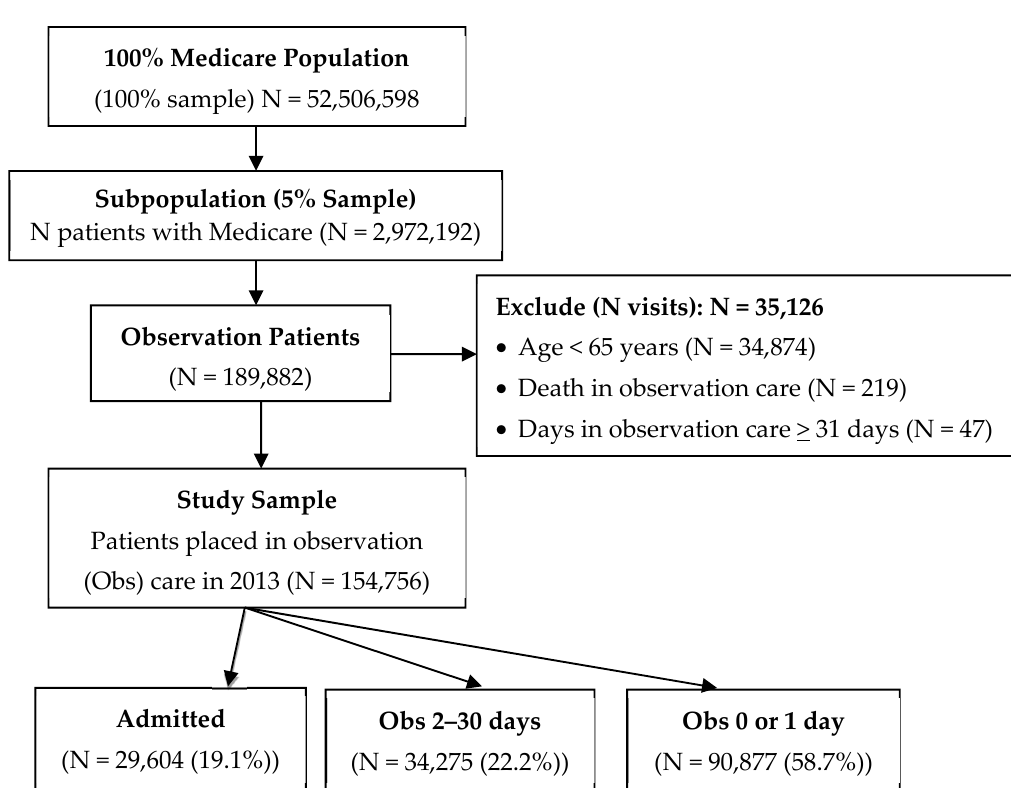
Figure A1. Study Cohort. The original sample of patients with Medicare insurance in 2013 is 52,506,598 individuals. The “Subpopulation” is the 5% sample distributed by the Centers for Medicare and Medicaid (N = 2,972,192). Of the subpopulation, patients in observation care were selected. Of the patients in observation care, the study sample was selected following the application of the exclusion criteria. Of the study sample patients, 19.1% were admitted to the hospital, 22.2% had an observation stay of 2–22 days, and 58.7% had an observation stay of 0–1 days. Table A1. CMS chronic Conditions.